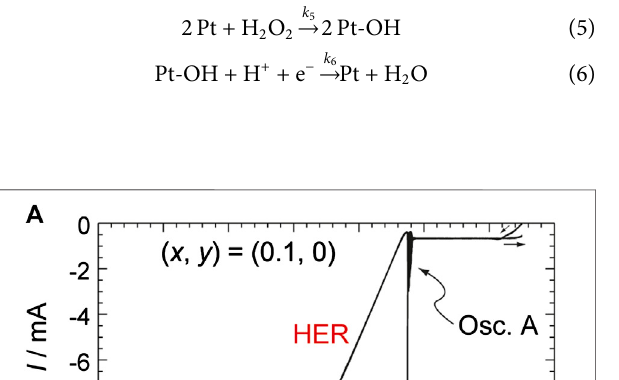
Frontiers in Energy Research |